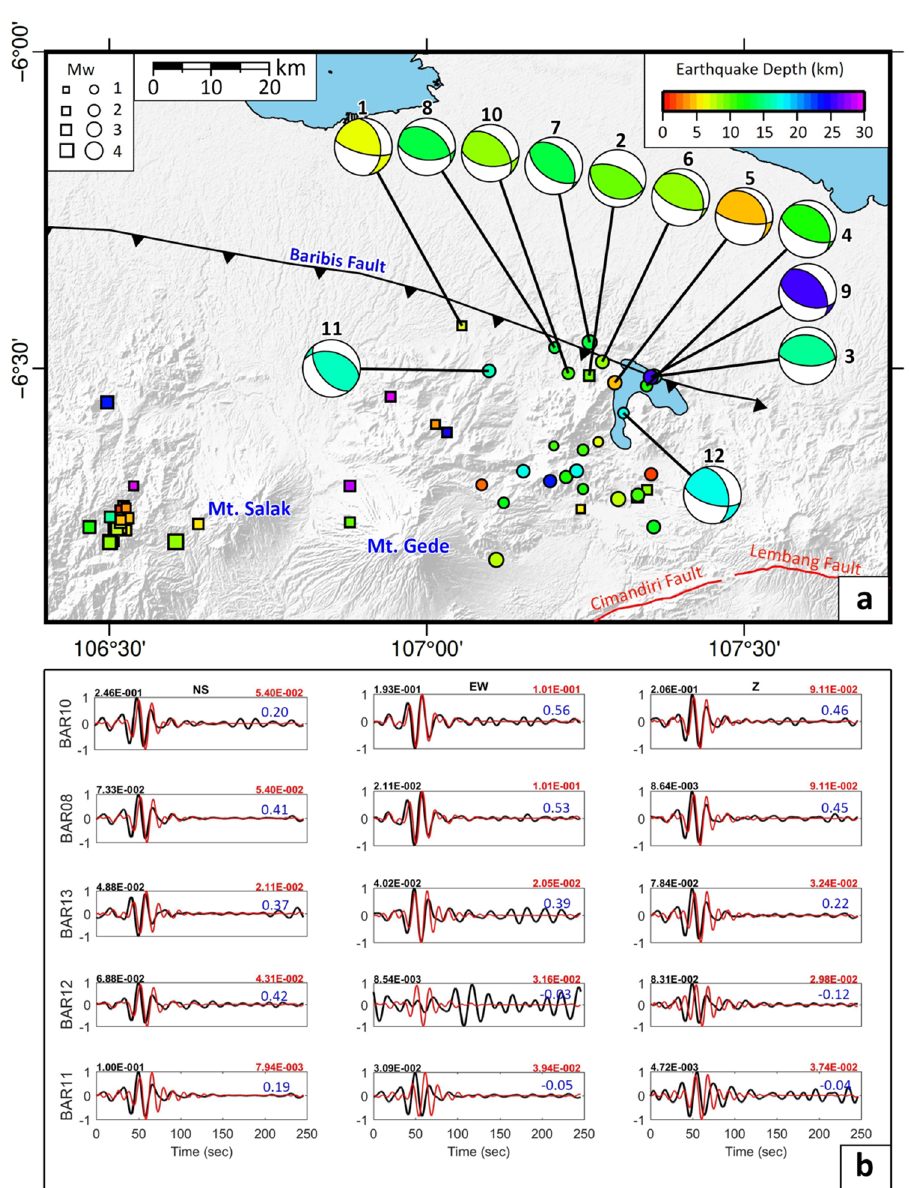
Figure 3. Focal mechanism analysis results. ( a ) Focal mechanism solutions for the earthquakes that occur along the Baribis Faults; two from Damanik et al. 18 (event no. 1–2, squares) and eight from this study (event no. 3–10, dots). ( b ) Example of three-component waveform inversions at stations BAR08, BAR10, BAR11, BAR12, and BAR13 for event no. 4 in ( a ) that occurred on 11 February 2021. Black and red waveforms are observed and synthetic waveforms, respectively. Blue numbers denote variance reduction that characterizes the match between the observed and best-fitting synthetic data. The black and red numbers above the panel of the waveform fitting are the peak amplitudes of observed and synthetic waveforms respectively. The y-axis denotes the normalized displacement. Note that events no. 3, 4, 8, 9, and 10 were recorded by borehole stations only. The rest were recorded by borehole and BMKG stations. The set of waveform fitting results for the remaining events are shown in Supplementary Figs. S10–S20, while the data acquisition plot for the first year and second year of the borehole station deployment is shown in Supplementary Fig. S21. The Generic Mapping Tools (GMT) version 6.0 59 (https:// www. gener ic- mappi ng- tools. org/) was used to make this